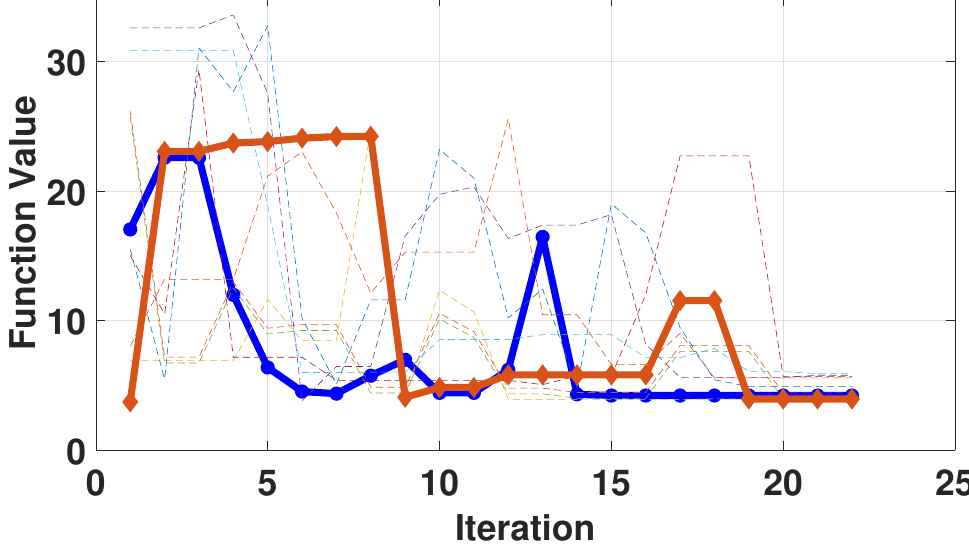
Figure 11. Iterative process of target imaging distance estimation based on simulated annealing algorithm. The MAG and corresponding estimated distances for this iteration process can be found in Table 5. From the graphical results and the iterative process, it can be revealed that the distance estimation algorithm proposed in this paper can satisfactorily estimate the target–instrument distance of the real imaging system and thus obtain accurate imag- ing